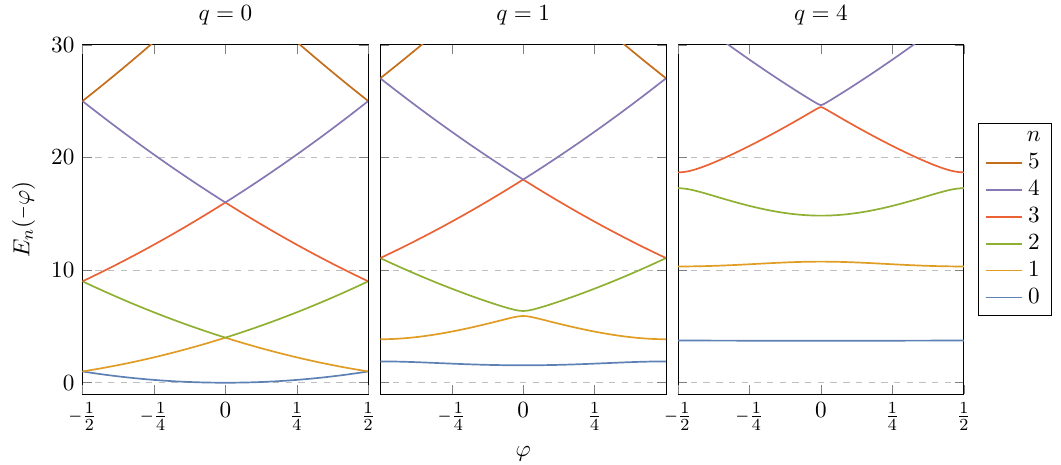
Figure 4. Energies of the various bands as a function of the gauge (cid:12)eld \mass gap" (cid:3), quanti(cid:12)ed by q (cid:3) = ( (cid:25) 2 g 2 ~ 2 ). As q increases, the gaps between the various bands appear and grow. For large q , (cid:17) the lowest energy band becomes \instanton-like," and is roughly a single cosine with exponentially suppressed